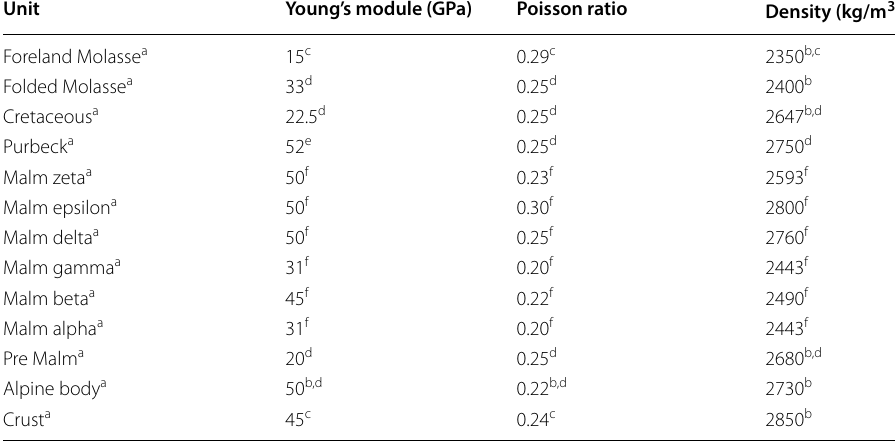
a Przybycin et al. (2017); b Przybycin et al. (2014); c Hergert et al. (2015); d Koch (2009); e Thuro et al. (2001); f Lama and Vutukuri (1978)